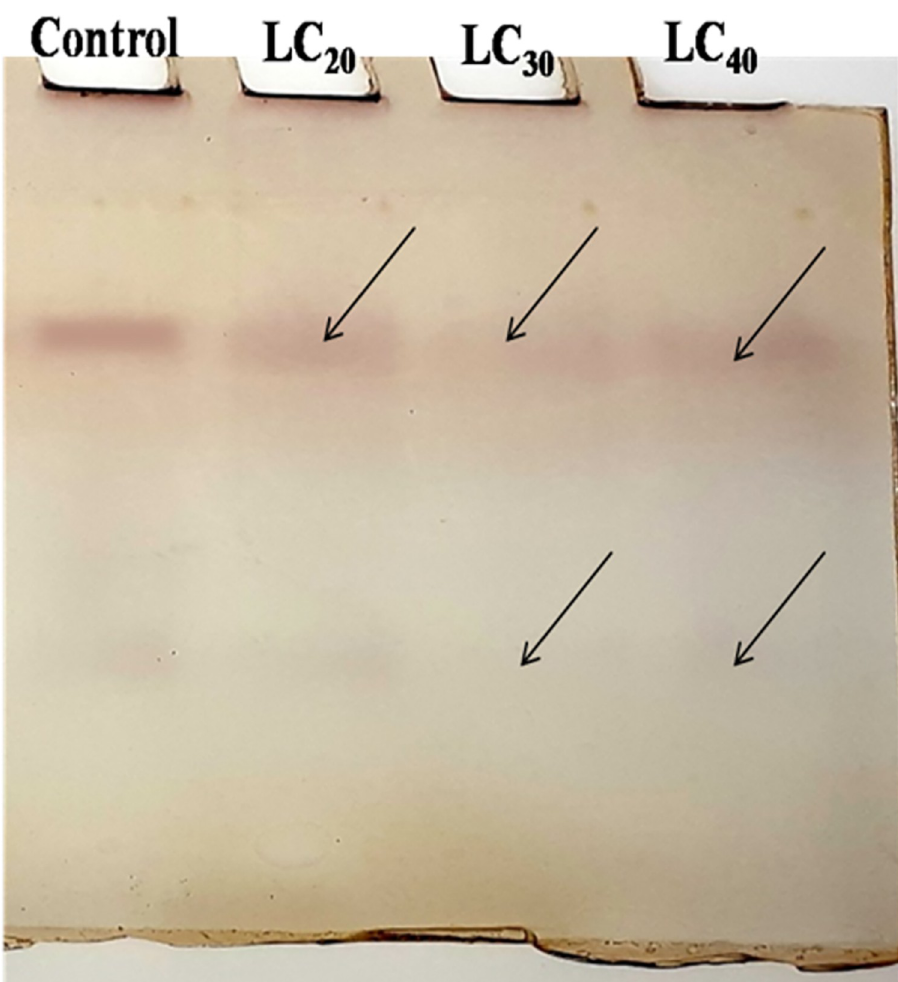
Fig 4. Qualitative analysis of alkaline phosphatases T . castaneum adult after treatment with essential oil of C . Citrinus